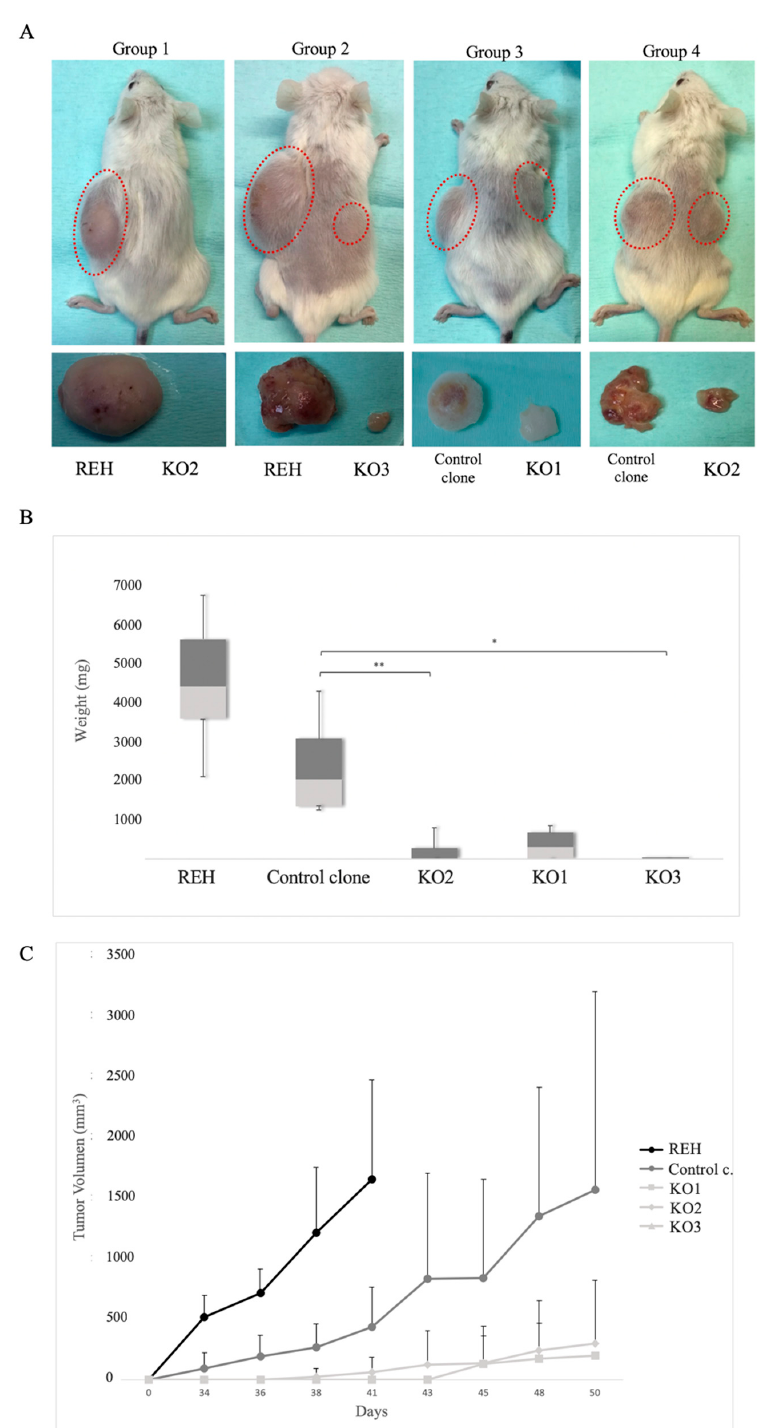
Figure 6. In vivo effects of CRISPR-mediated editing of the E / R oncogene. ( A ) External appearance of mice and developed tumours 48–62 days after subcutaneous cell injection. Tumours formed by KO clones (right flank) were smaller than those induced by REH cells or control clones (control c.) (left flank). Each group had four mice. ( B ) Evolution of tumour growth measured every 2–3 days until the moment in which mice were sacrificed. ( C ) Representation of the mean tumour size corresponding to each clone, independently of the group. * p ≤ 0.05; ** p ≤ 0.005 (unpaired t -test).